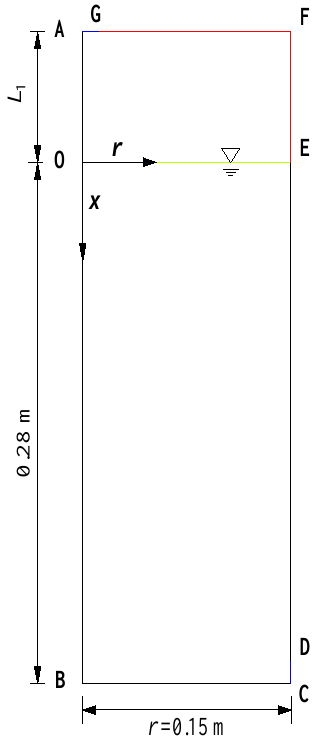
Figure 1. A schematic of the computational domain.